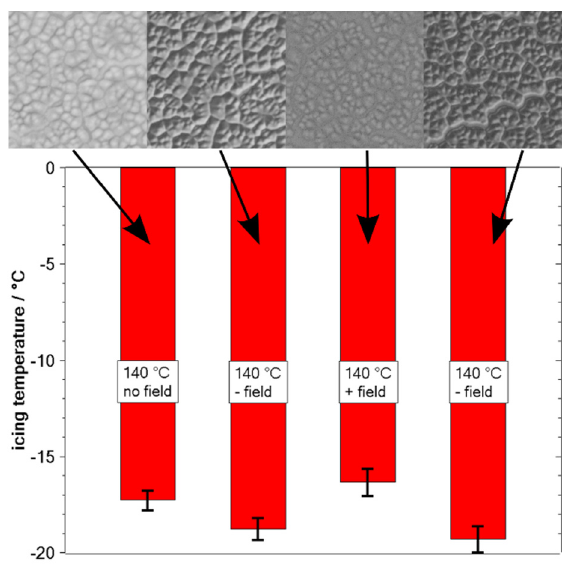
Figure 9. Correlation between electric field direction during thermal treatment, freezing temperature, and surface appearance under light